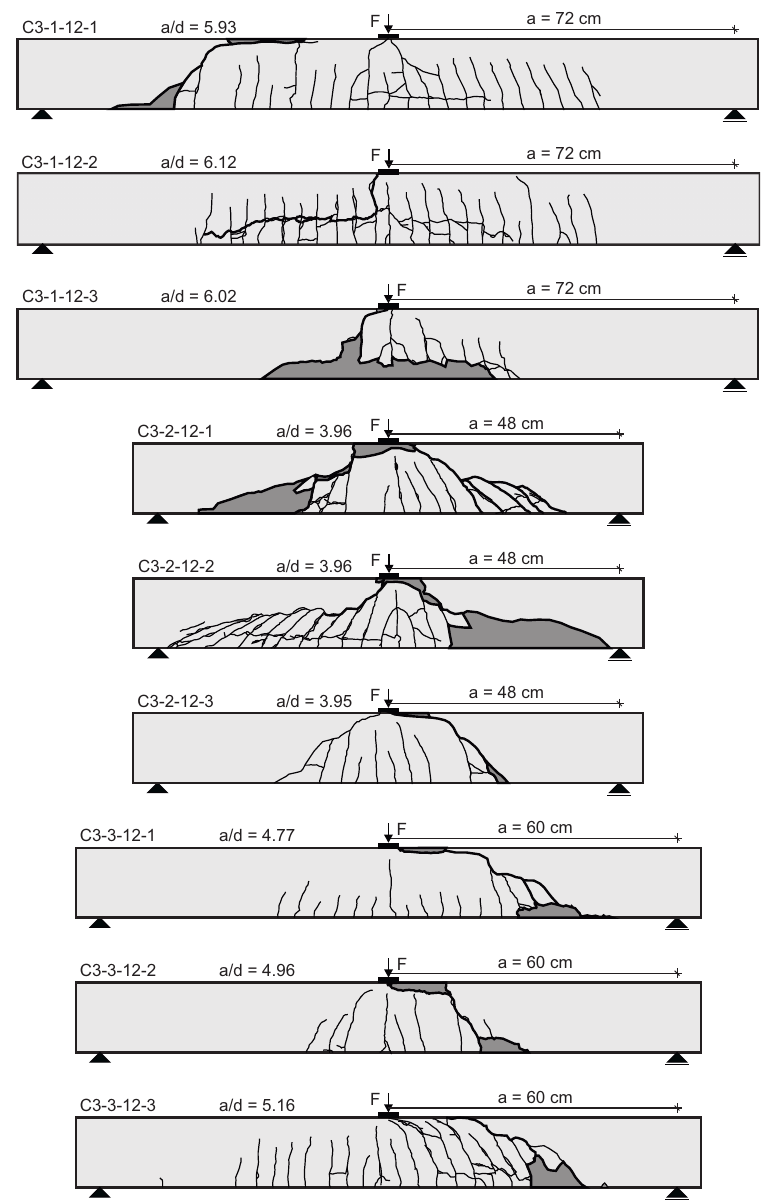
Figure 5. Crack pattern and failure mechanism for d = 12 cm shear test series.